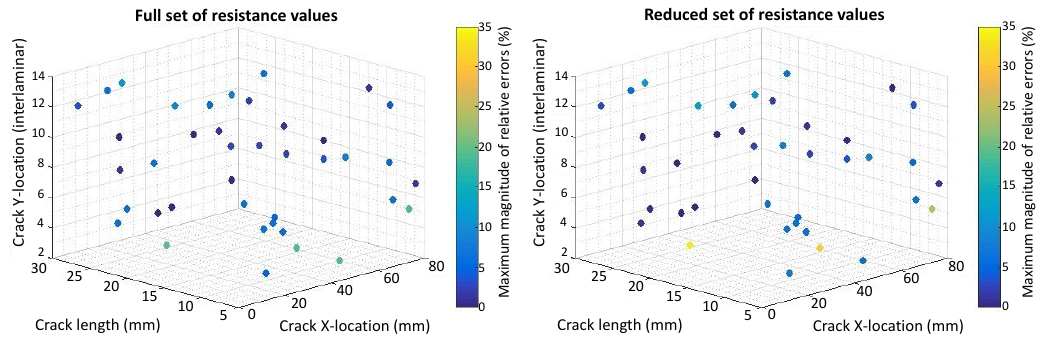
Figure 7. Scatter plot with maximum magnitude of relative errors obtained at the 40 test points used for inverse identification in a [ 0 4 /90 4 ] s laminate using eight electrodes and considering: ( left ) Full resistance measurement set; ( right ) Reduced resistance measurement set using